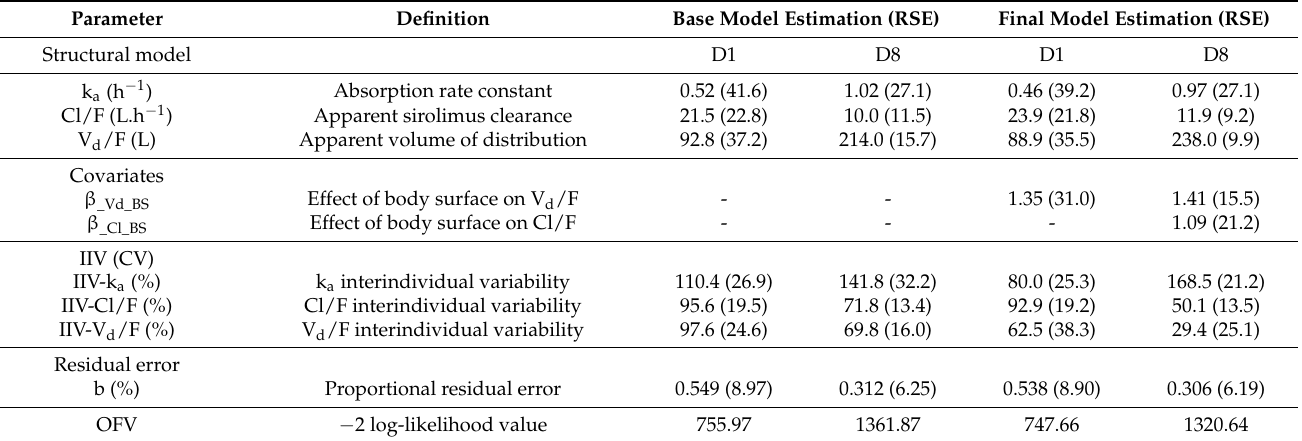
Table 3. Base and final models estimation on D1 and D8 of sirolimus